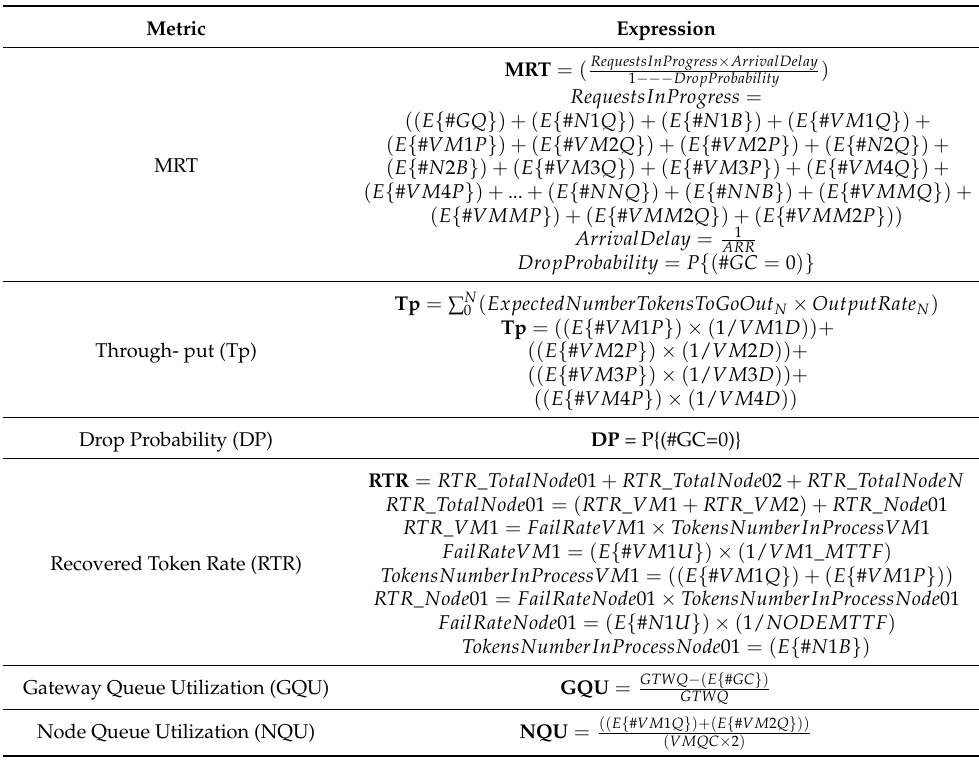
Table 4. Metrics used in the model.